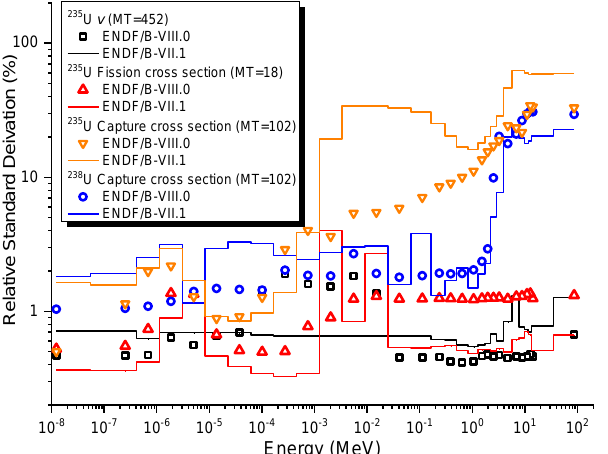
Figure 5. Comparison of the microscopic cross section uncertainties between ENDF/B-VIII.0 and ENDF/B-VII.1.